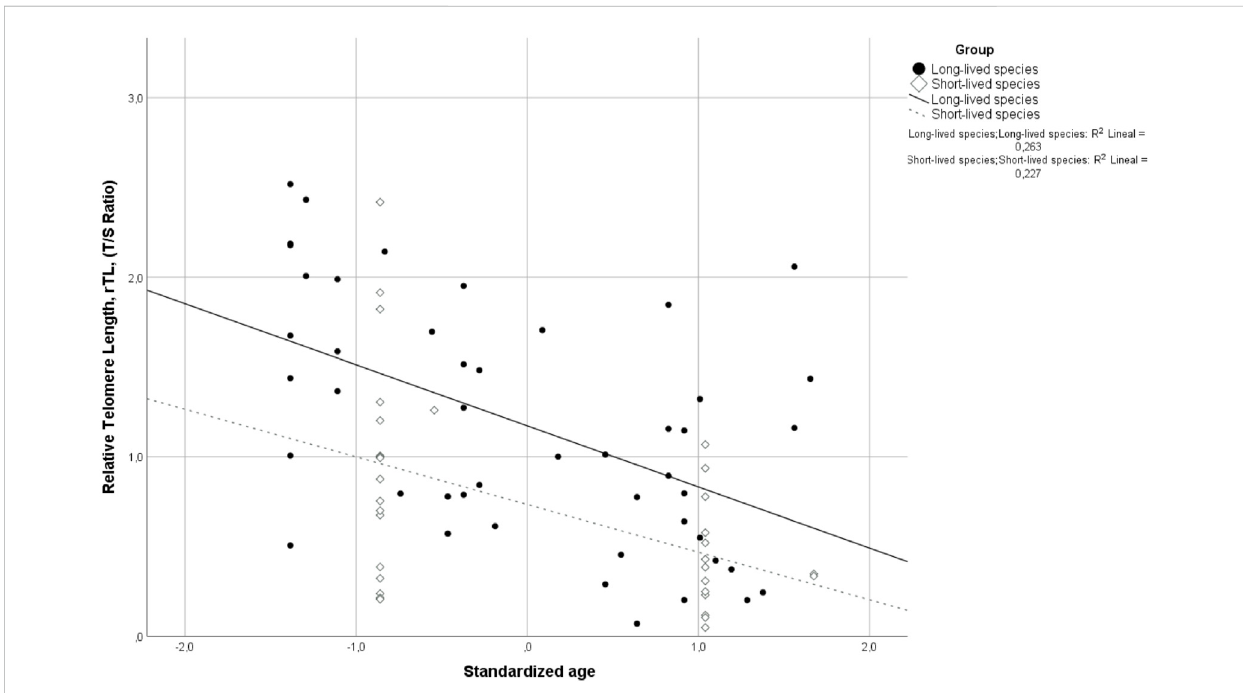
FIGURE 1 Correlation between relative telomere length (rTL) and standardized age for long- and short-lived birds. Spearman ’ s coef fi cient correlation (R = − 0.472, p < 0.001) includes both long- and short-lived birds.